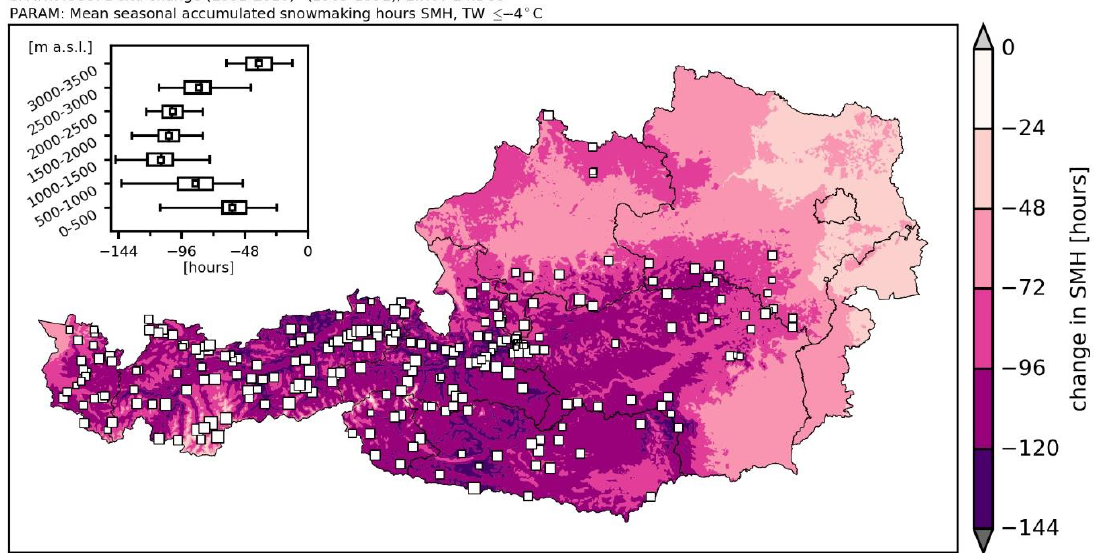
Figure 11. Change in accumulated snowmaking hours (number of hours with a wet bulb temperature ≤−4 °C) for the period 1 November–24 December for the two time slices 1991–2020 vs. 1961–1990. The colors represent the absolute change. The calculation of the snowmaking hours is based on the gridded observational dataset SPARTACUS. White squares indicate the approximate location of most Austrian skiing resorts as of the year 2008 (© data.umweltbundesamt.at; [63]) with the square size proportional to the size of the skiing resort.